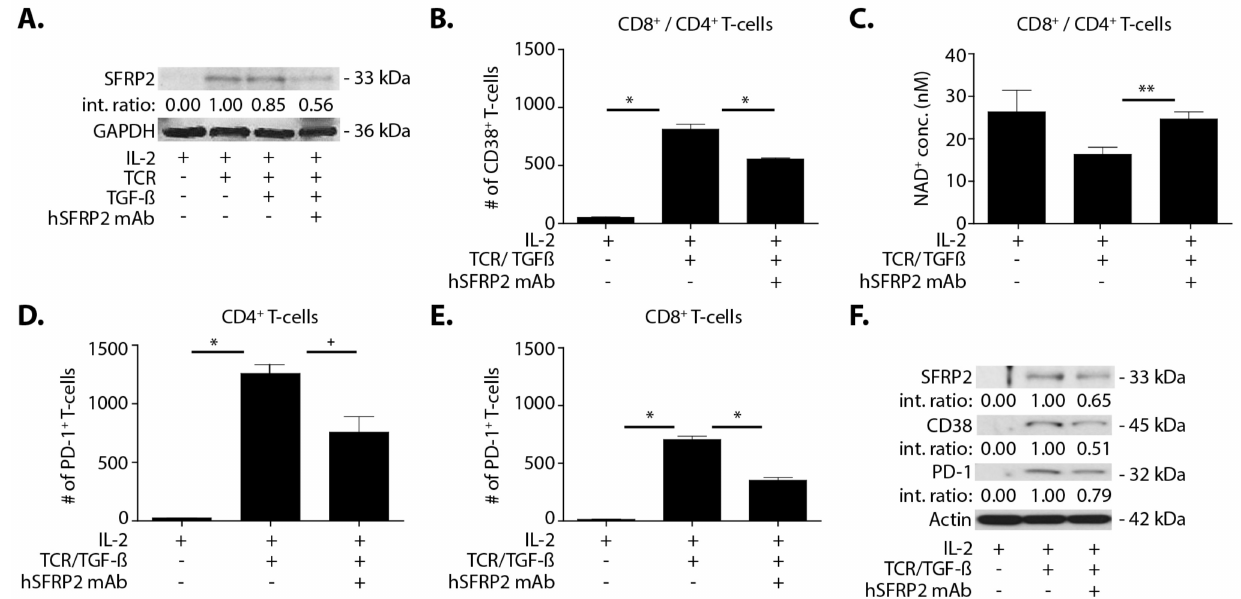
Figure 7. Humanized SFRP2 mAb inhibits TCR/TGF β -induced elevation of CD38 and PD-1 in T-cells. ( A ) Western blot showing the levels of SFRP2 protein in T-cells treated either with IL-2 (6000 U/mL) alone, IL-2 + TCR, IL-2 + TCR + TGF β (5 ng/mL) or IL-2 + TCR + TGF β + hSFRP2 mAb (30 nM). Loading control: GAPDH. Int. ratio: intensity ratios listed below SFRP2 Western blot were calculated after normalization to both GAPDH and the reference sample (indicated by 1.00). T-cell activation by TCR/TGF β increases the levels of SFRP2 protein, which are decreased by hSFRP2 mAb treatment. ( B ) FACS analysis showing the levels of CD38 in CD8 + /CD4 + T-cells after incubation with IL-2 alone, IL-2 + TCR/TGF β or IL-2 + TCR/TGF β + hSFRP2 mAb. CD38 protein levels increase upon activation by TCR/TG β , compared to control ( n = 3, * p < 0.001), and this effect is abrogated by treatment with hSFRP2 mAb ( n = 3, * p < 0.001). ( C ) NAD + concentration was measured using an NAD + /NADH cell-based assay kit on T-cells exposed to IL-2 alone, IL-2 + TCR + TGF β or IL-2 + TCR + TGF β + hSFRP2 mAb. T-cell activation by TCR/TG β led to a decrease in NAD + concentration compared to IL-2, which was restored by hSFRP2 mAb treatment ( n = 3, ** p = 0.02). PD-1 levels were measured by FACS in ( D ) CD4 + and ( E ) CD8 + T-cells exposed to IL-2 alone, IL-2 + TCR + TGF β or IL-2 + TCR + TGF β + hSFRP2 mAb. In both cell types, T-cell activation by TCR/TGF β induced an increase in PD-1 protein levels ( n = 3, * p < 0.001), which was reduced by hSFRP2 mAb treatment ( n = 3, + p <0.05) in CD4 + cells ( D ) and n = 3, * p < 0.001 in CD8 + cells ( E ). ( F ) Results obtained by FACS analysis on T-cells exposed to IL-2 alone, IL-2 + TCR + TGF β or IL-2 + TCR + TGF β + hSFRP2 mAb were confirmed by Western blot for the indicated markers. TCR/TGF β activation led to an increase in SFRP2, CD38 and PD-1 protein levels, which were reduced by hSFRP2 mAb treatment. Loading control: actin. Int. ratio: intensity ratios listed below SFRP2, CD38 and PD-1 Western blots were calculated after normalization to both actin and the reference sample (indicated by